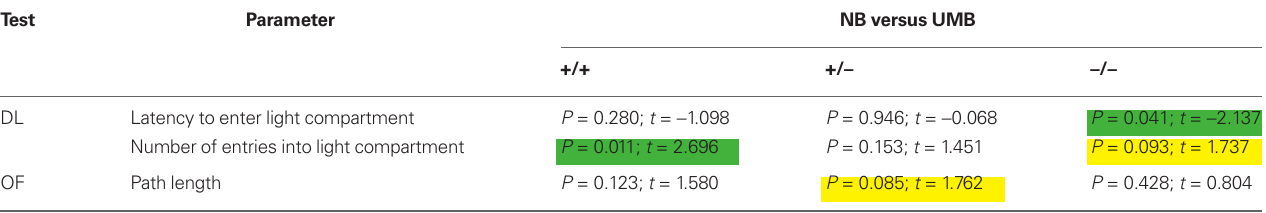
Table 2 | Pairwise comparisons between treatment groups. Direction of signifi cant differences see text.